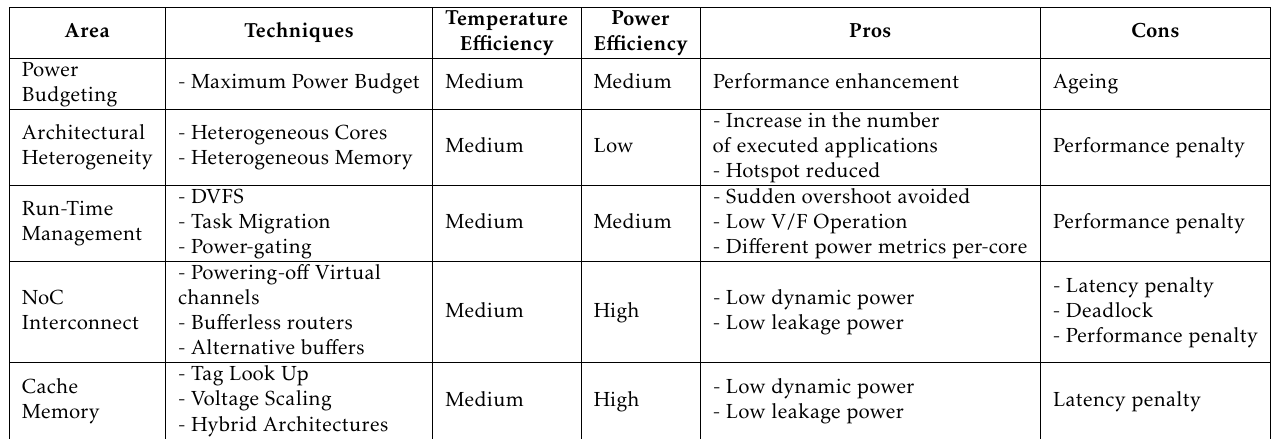
Table 1. A summary of DSCS